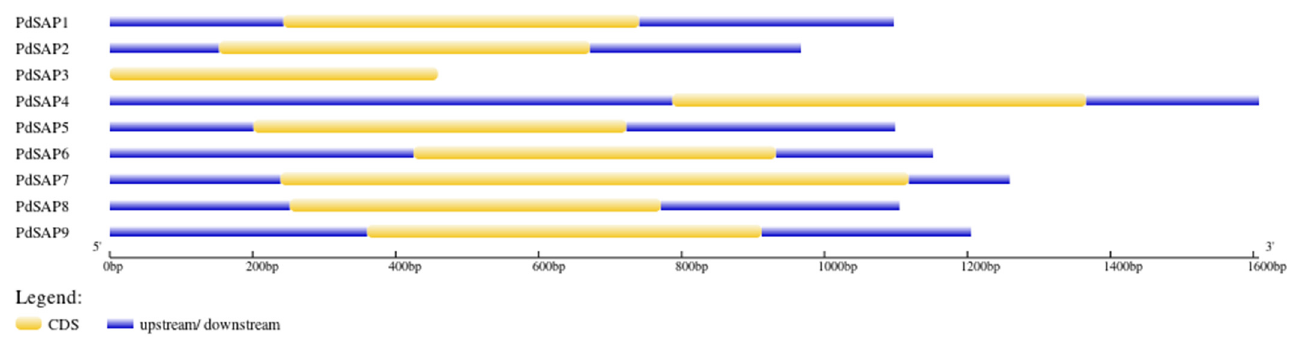
Figure 6. PdSAP gene structure prediction. Exons are in yellow. PdSAP genes lacked intronic regions. Blue represents the 5 ′ and 3 ′ untranslated regions (UTRs). MCScanX revealed no duplication blocks in the P. dulcis genome. The TBTool was used to perform synteny analysis of P . dulcis with the genomes of P . persica , A . thaliana , J .